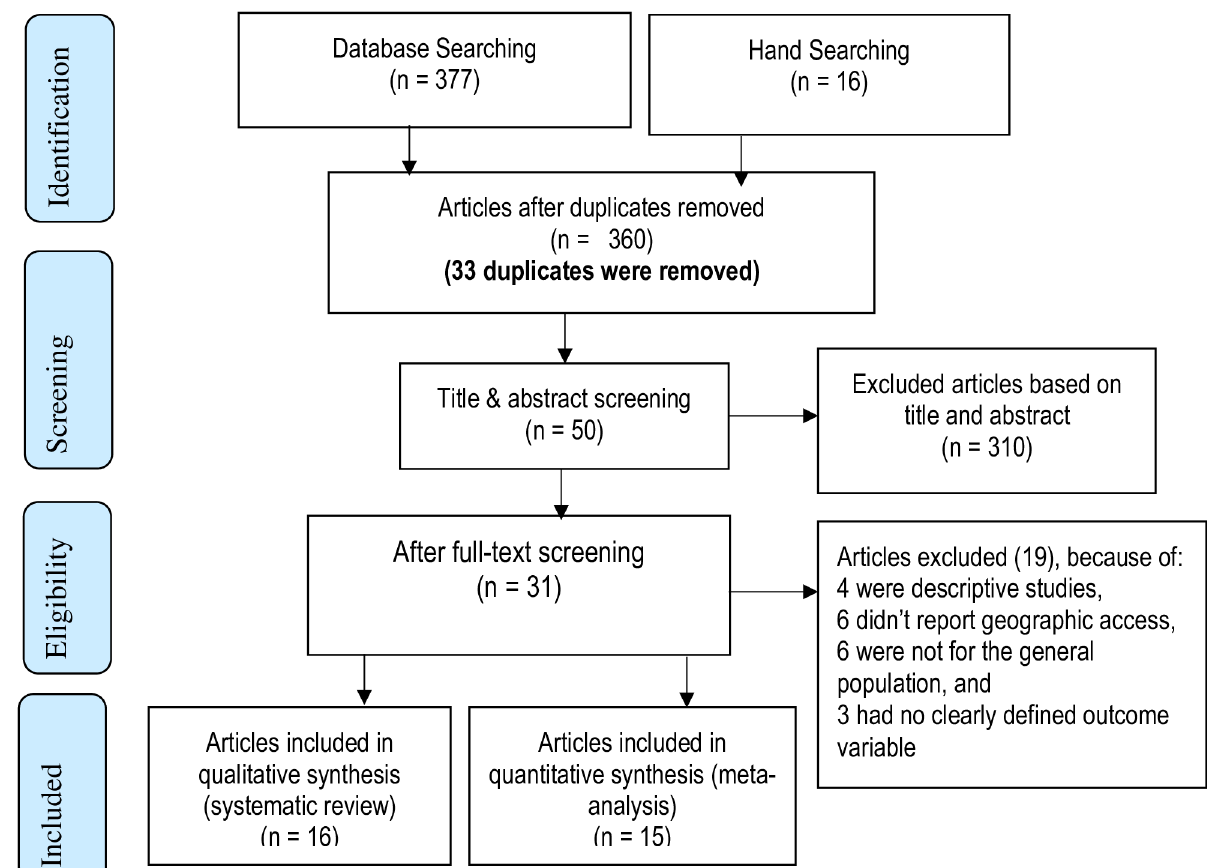
Fig 1. Systematic review and meta-analysis flow diagram adapted from the 2009 PRISMA statement (42).